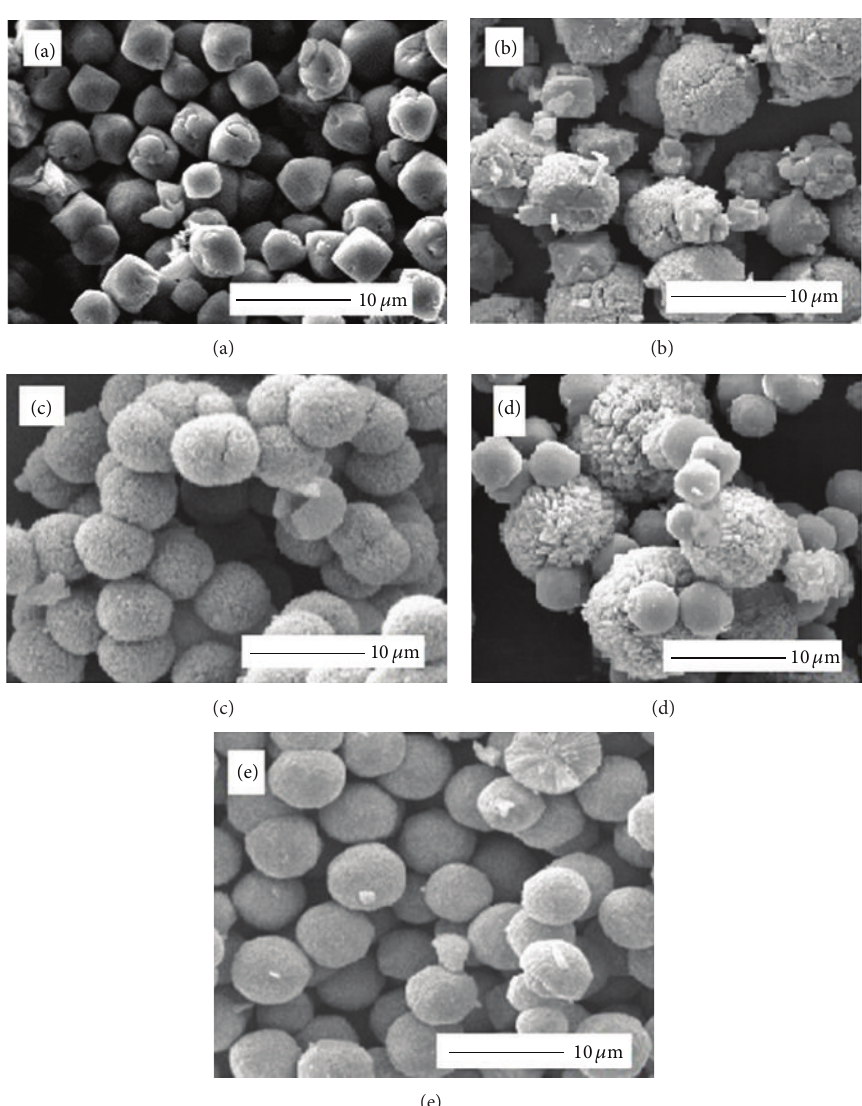
Figure 1: Scanning electron micrographs of synthesized zeolites at different temperatures: (a) 90 ∘ C, (b) 96 ∘ C, (c) 100 ∘ C, (d) 110 ∘ C, and (e) 130 ∘